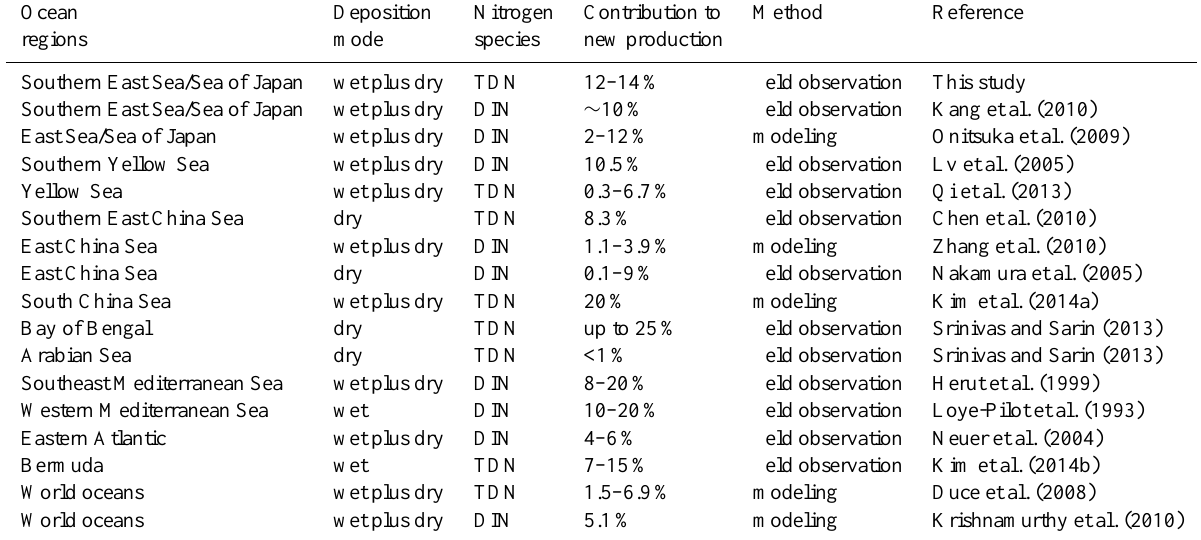
Table 5. Fractions of new primary production supported by atmospheric nitrogen input in world oceans on an annual basis.